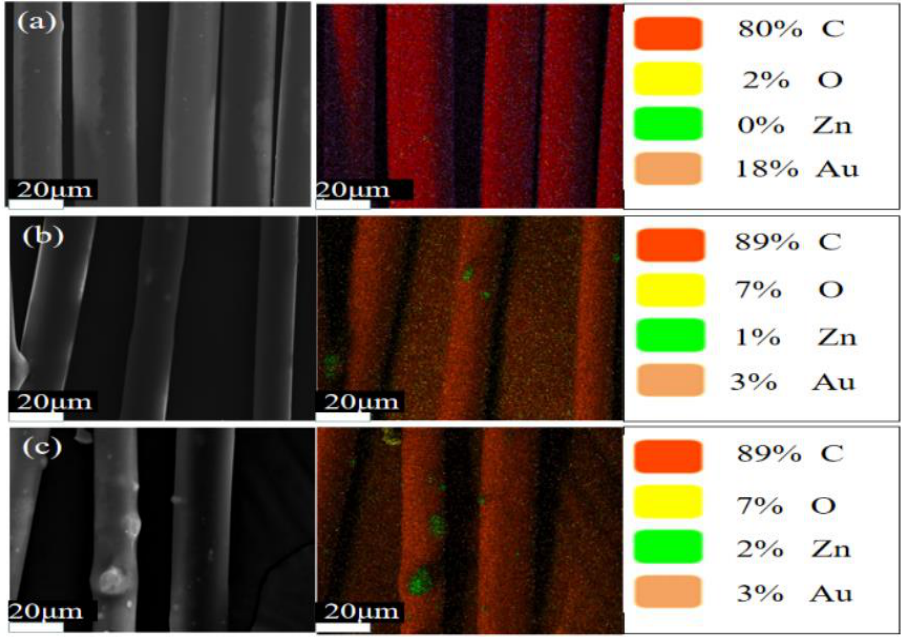
Figure 4. SEM/energy-dispersive spectroscopy (EDS) patterns of PP e-spun fibers containing ZnO: ( a ) 0 wt.%; ( b ) 1 wt.%; ( c ) 3 wt.%.